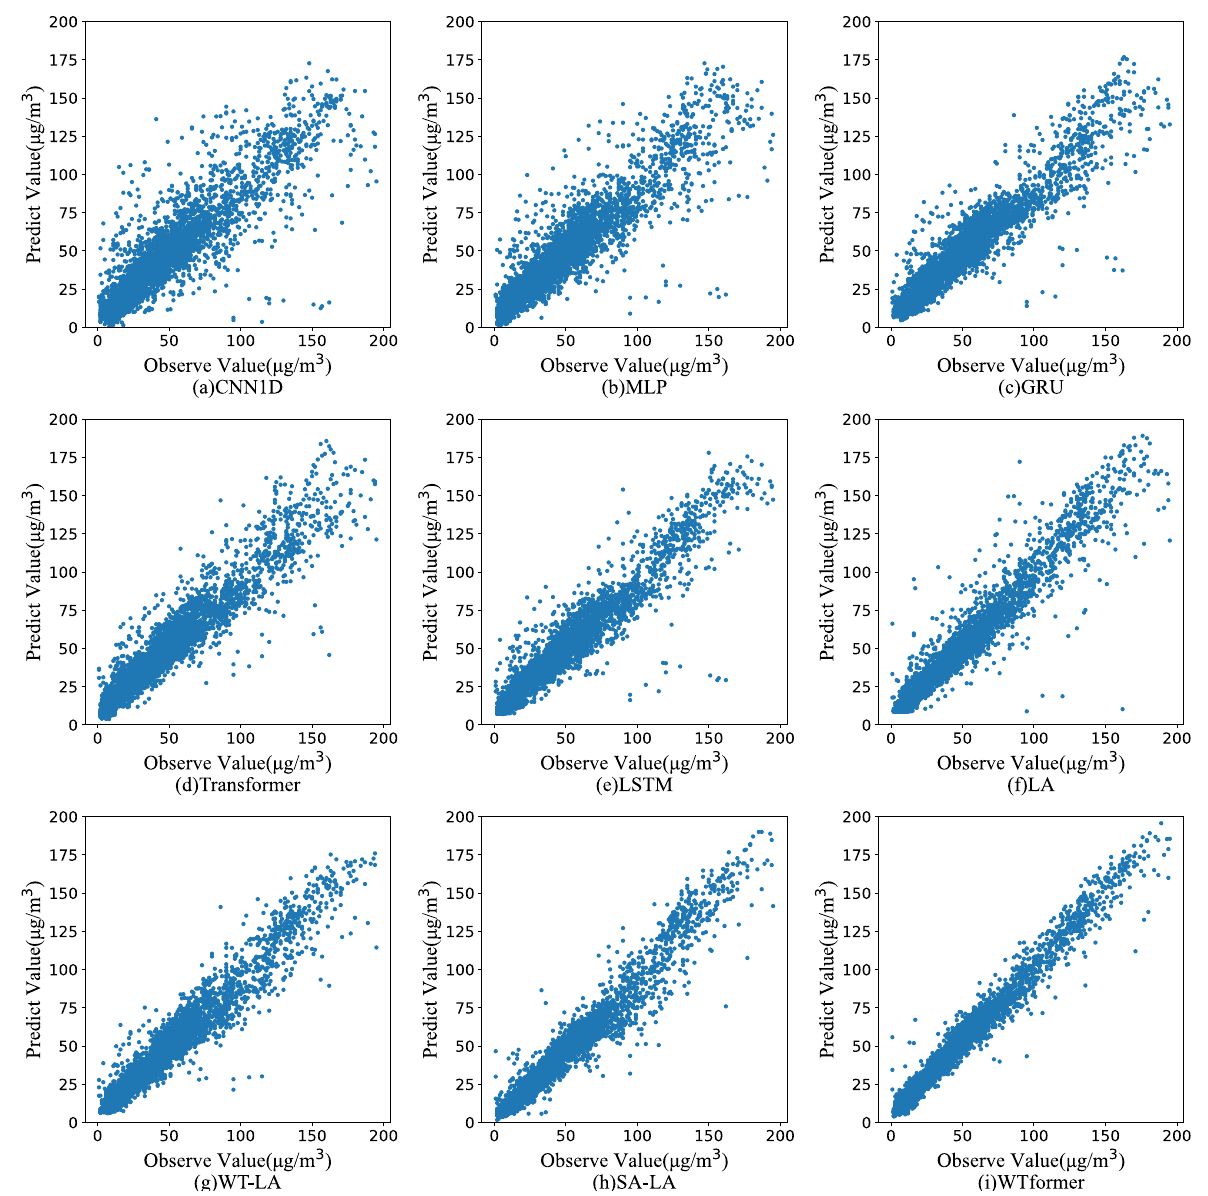
Figure 13. The comparison of the predicted values for each model with the observed